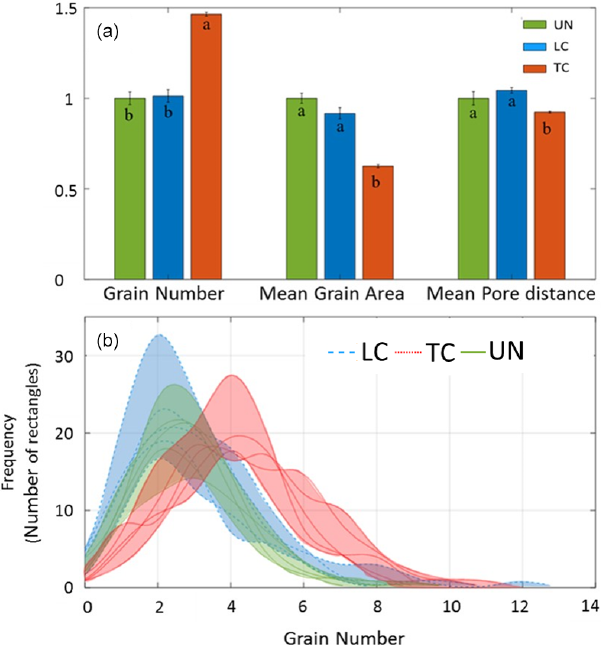
Figure 4. (a) Average grain number, average grain area, and aver- age pore distance of the uncompacted soil sample (UN), low (LC), and top (TC) levels of compacted soil samples. Measured values were normalized with respect to UN. (b) Histogram represents grain number distribution of the uncompacted soil samples and low and top levels of the compacted soil samples. In (b) , each line is the his- togram of a single slice, and the colored areas represent the range of the five measured histograms for each